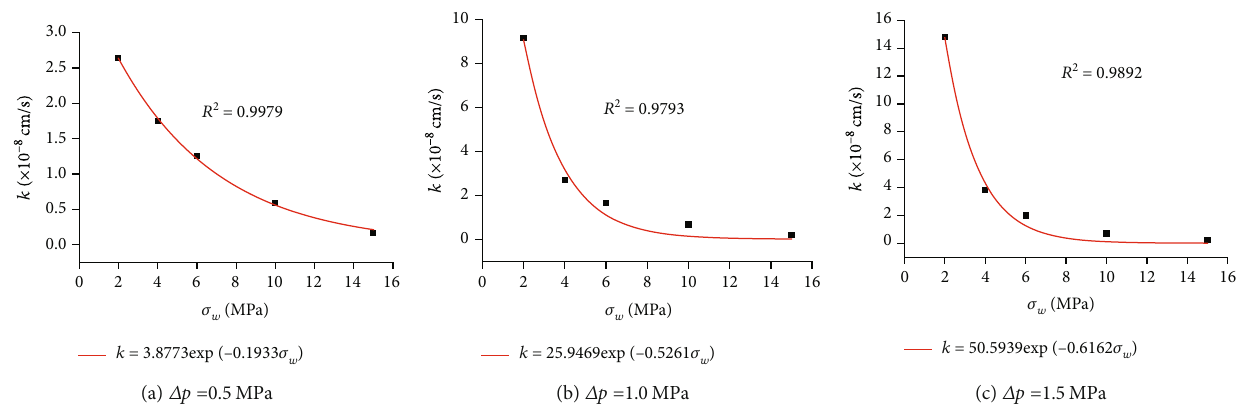
Figure 20: Relationship between permeability coe ffi cient and con fi ning stress under constant water pressure.